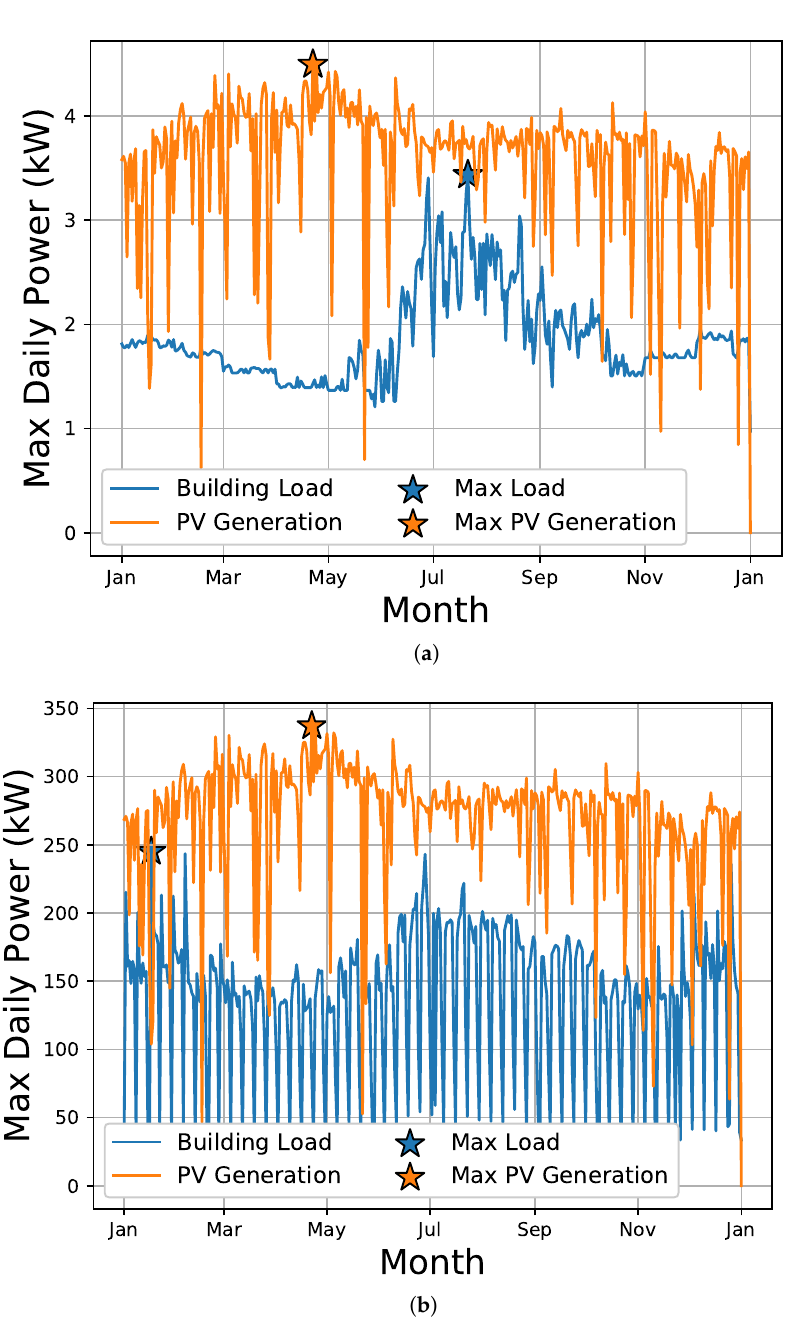
Figure 3. The residential and commercial building’s photovoltaic (PV) systems each generated a maximum amount of power that was larger than the load. The PV systems were sized to offset the annual energy consumption and therefore did not match the load on a daily basis. For each building type, the maximum generated PV power exceeded the largest load demand by a factor of 135%. ( a ) Residential building’s estimated load reached a maximum in July (blue star) and the PV generation largest value occurred in April (orange star). ( b ) The commercial building’s maximum daily load occurred in Febuary (blue star) and the highest power generation of the PV happened in April (orange